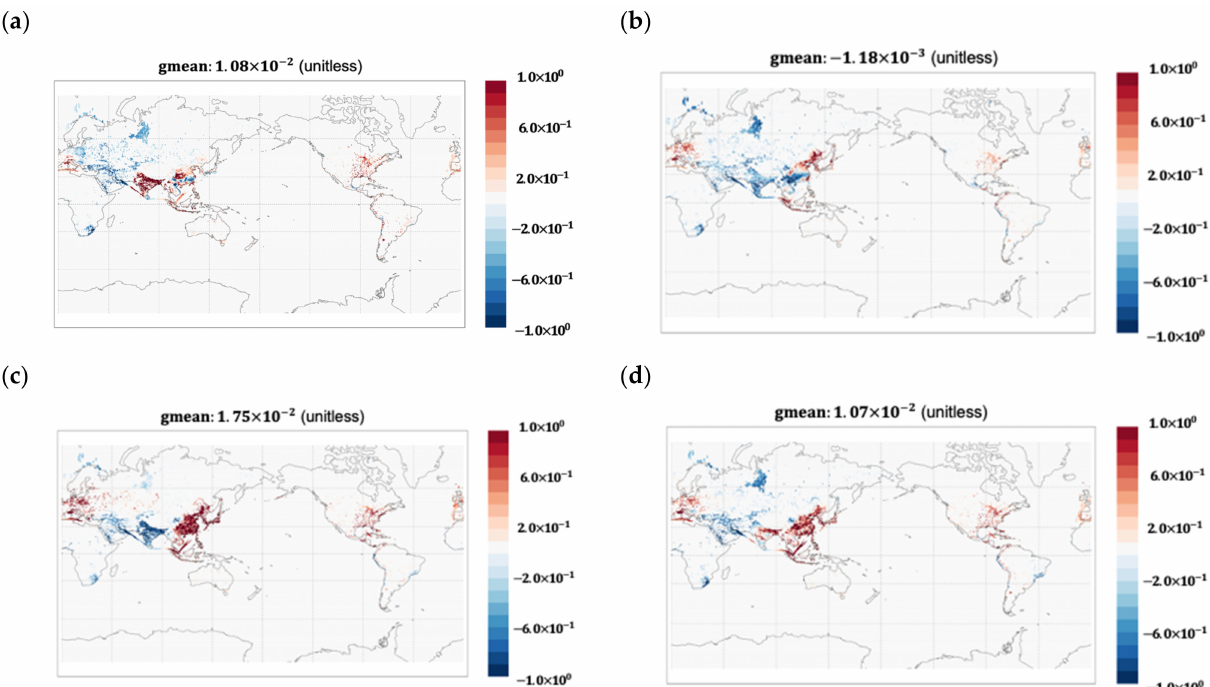
Figure 6. Global distribution of the fractional differences in SO 2 emissions, x -1, in ( a ) DJF, ( b ) MAM, ( c ) JJA, and ( d ) SON of